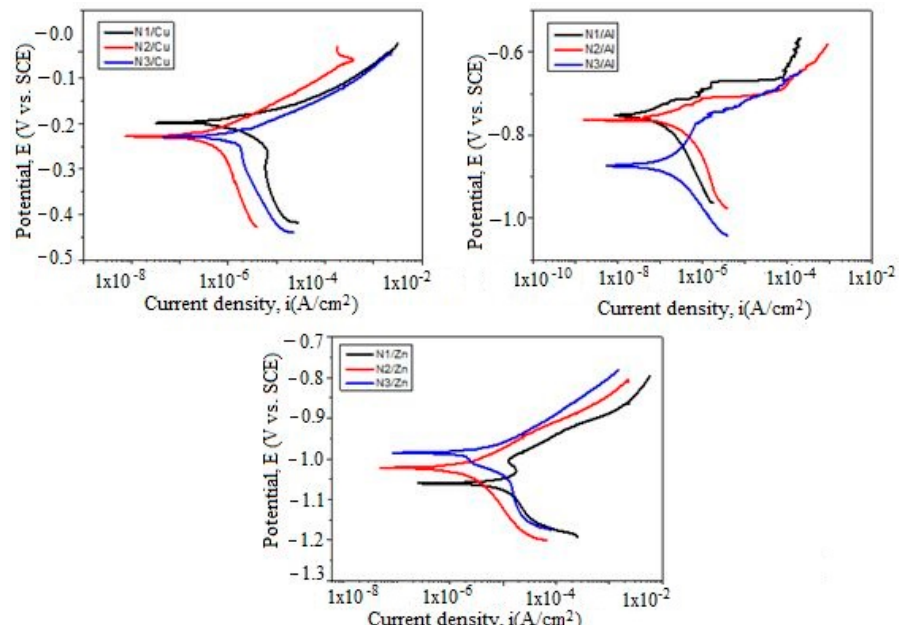
Figure 5. Tafel curves of metallic surfaces (Al, Cu, Zn) coated with sol-gel modified materials: N1